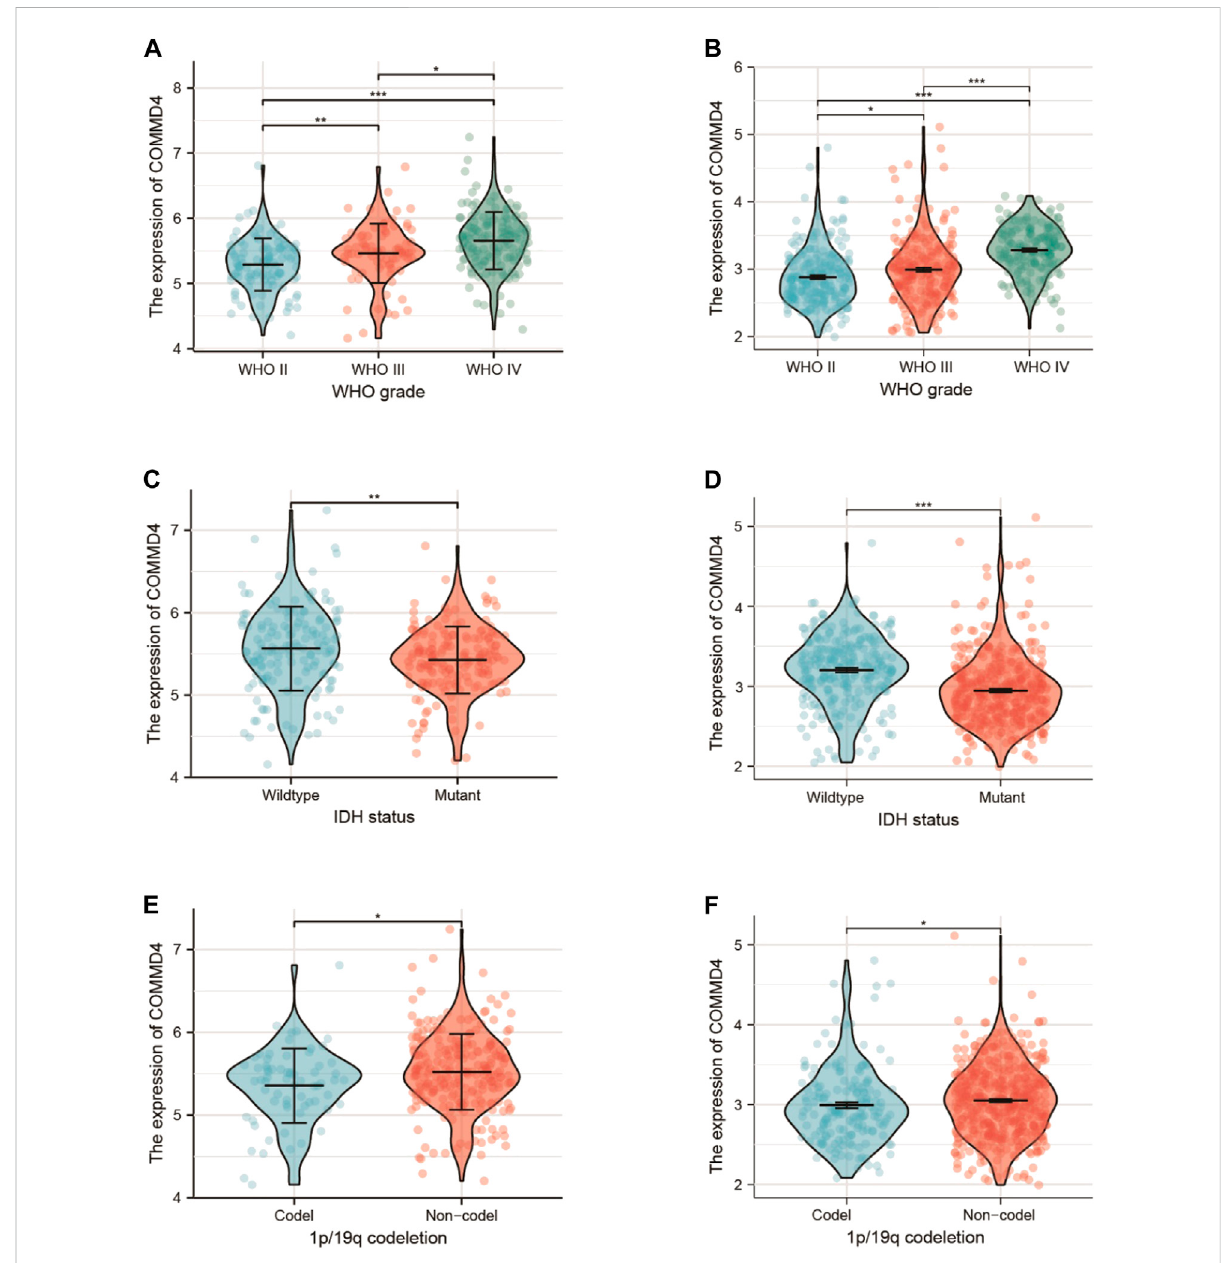
FIGURE 2 Expression of COMMD4 in CGGA (A) WHO grades. (C) IDH status-strati fi ed distribution. (E) 1p/19q-codeletion status distribution. COMMD4 expression in TCGA (B) WHO grades. (D) IDH status-strati fi ed distribution. (F) 1p/19q-codeletion status distribution.